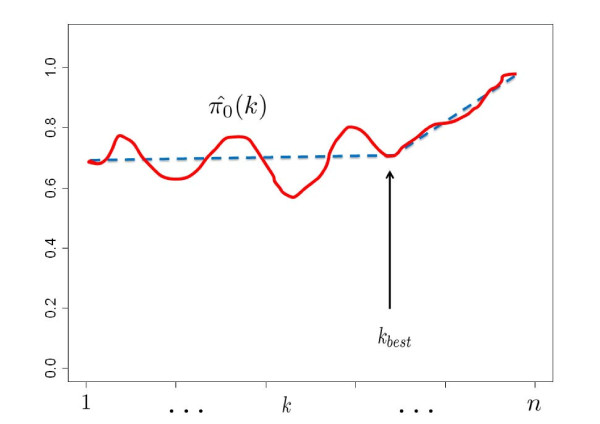
Illustration of choosing kbest using k vs.  plot. The blue dashed line indicates the ideal π0 estimated for different choice of k. The red curve indicates the actual .